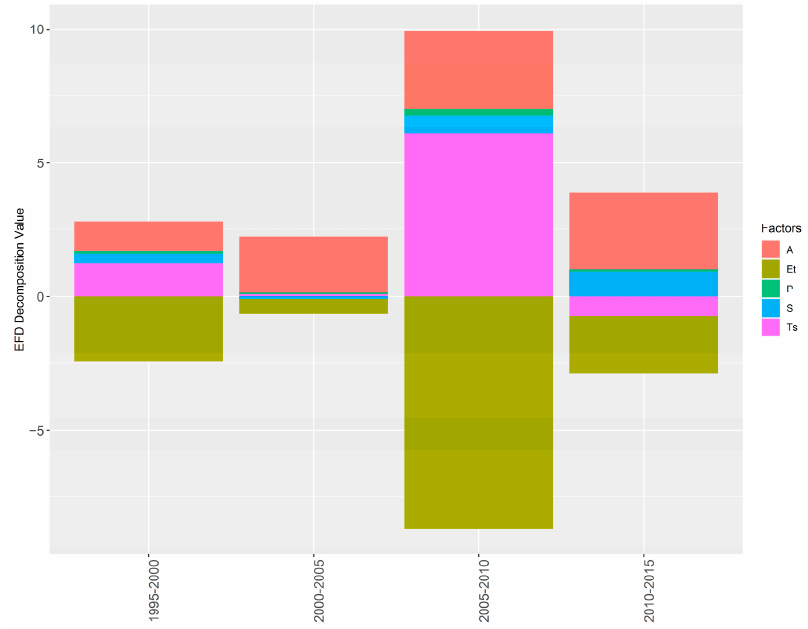
Figure 6. LMDI decomposition of Jiangsu’s overall EFD changes from 1995-2015.